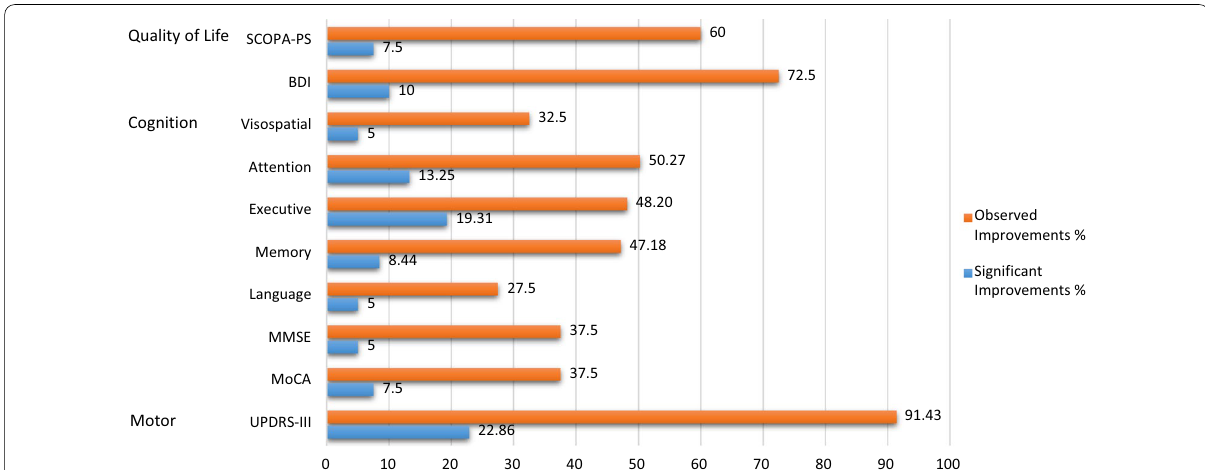
Fig. 1 Percentage of PD‑patients (total) showing observed and significant improvements in cognitive performance after intervention compared to performance before. “Observed improvements” are seen in patients showing improvements in raw scores, indicating a trend, which, however, cannot be obtained statistically. “Significant improvements” are seen in patients who did show improvements calculated using the RCI method. Most patients showed unchanged cognitive performance (z score 1.645 to 1.645). A low proportion of patients showed non‑significant ≥ ≤ improvements (z score 1.645) after intervention; The percentage of patients presenting with significant improvement (z score 1.645) after ≤ ≥ intervention was observed mainly in motor function and time‑dependent tasks related to attention and executive functions. BDI ‑II, Beck’s depression inventory; MMSE Mini mental state examination, MoCA Montreal cognitive assessment; SCOPA-PS Scales for outcomes in Parkinson’s disease—Psychosocial questionnaire, UPDRS Unified Parkinson’s disease rating scale. Overview composites: see Table